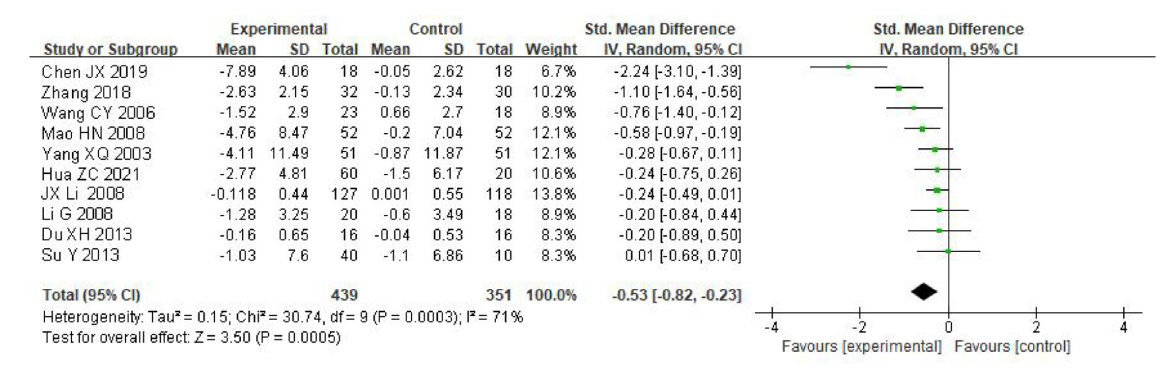
FIGURE3 Forest plot of the effect of taijiquan on college students’ depression.